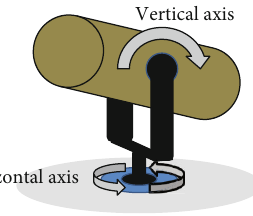
Figure 1: The telescope on an azimuth